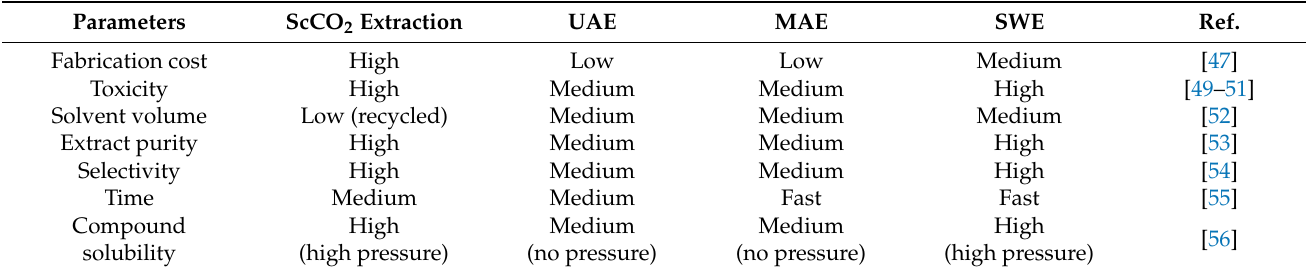
Figure 3. Four principles of eco-friendly extraction. Table 1. Comparison of ScCO 2 extraction with traditional methods.